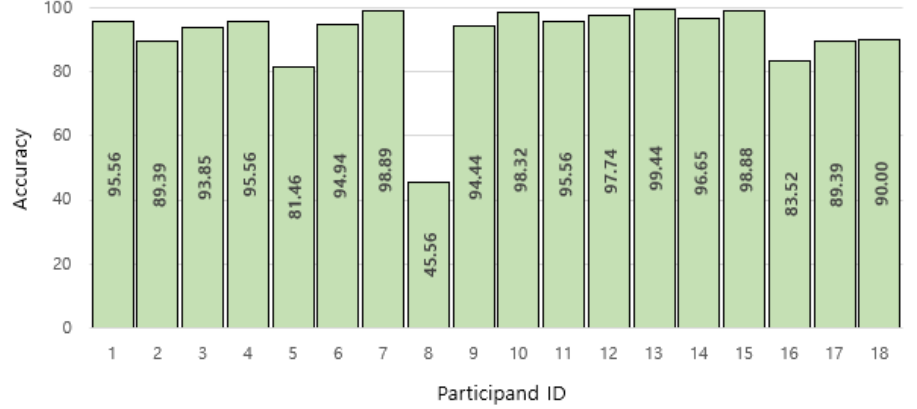
Figure 13. Examples of misclassified and correctly classified signals of characters. Accuracies also varied according to the participants (see Figure 14). The accuracies of the 13 participants were higher than 90%; four participants had accuracies between 80% and 90%, and one (participant #8) had 45.56%, which is approximately half of the average.